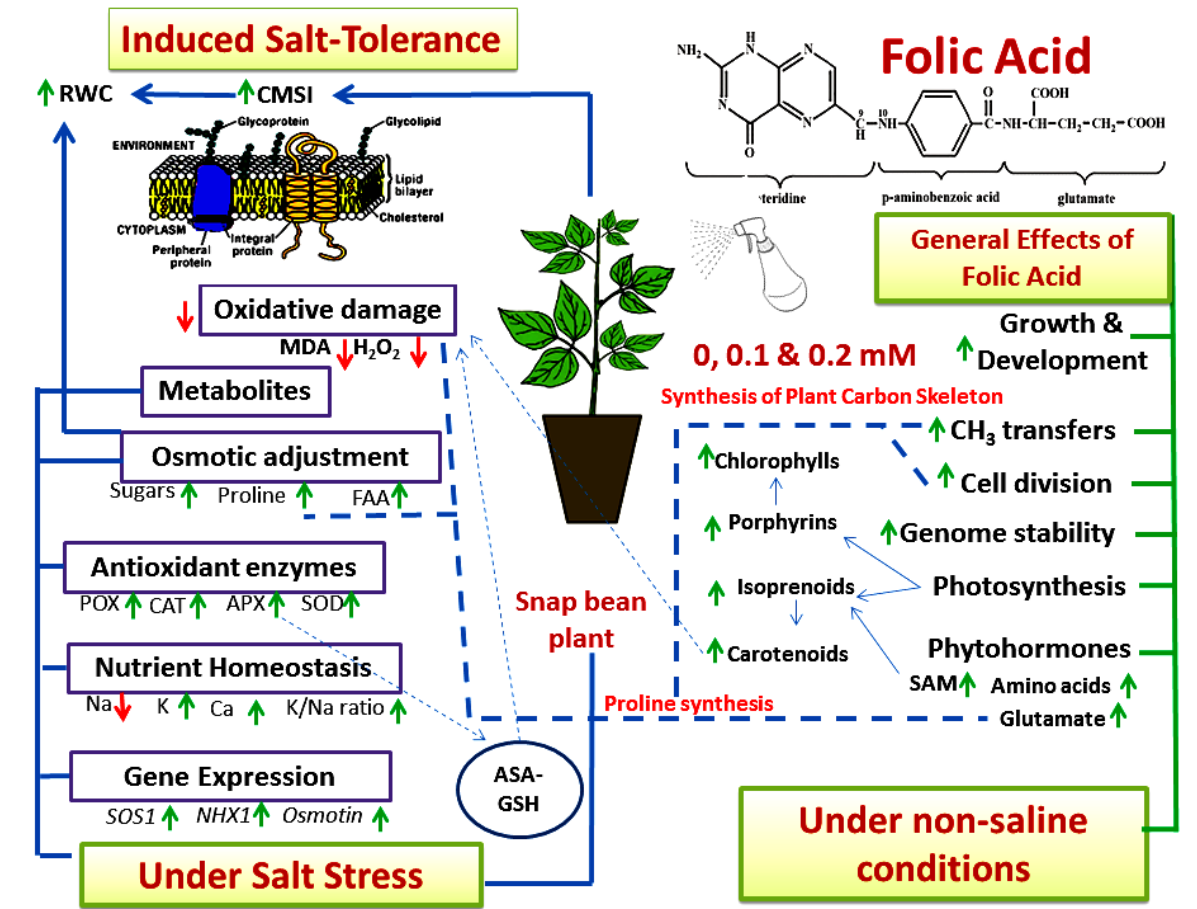
Figure 8. Simplified model for the suggested effect of exogenous folic acid as a foliar spray on snap bean plants grown under salinity stress. RWC, relative water content; CMSI, cell membrane stabil- ity index; SAM, S-adenosylmethionine; MDA, malondialdehyde; FAA, free amino acids; POX, pe- roxidase; CAT, catalase; APX, ascorbate peroxidase; SOD, superoxide dismutase;